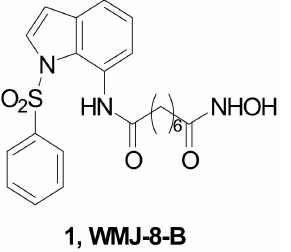
Figure 4. Chemical structure of the HDAC4/6 inhibitor